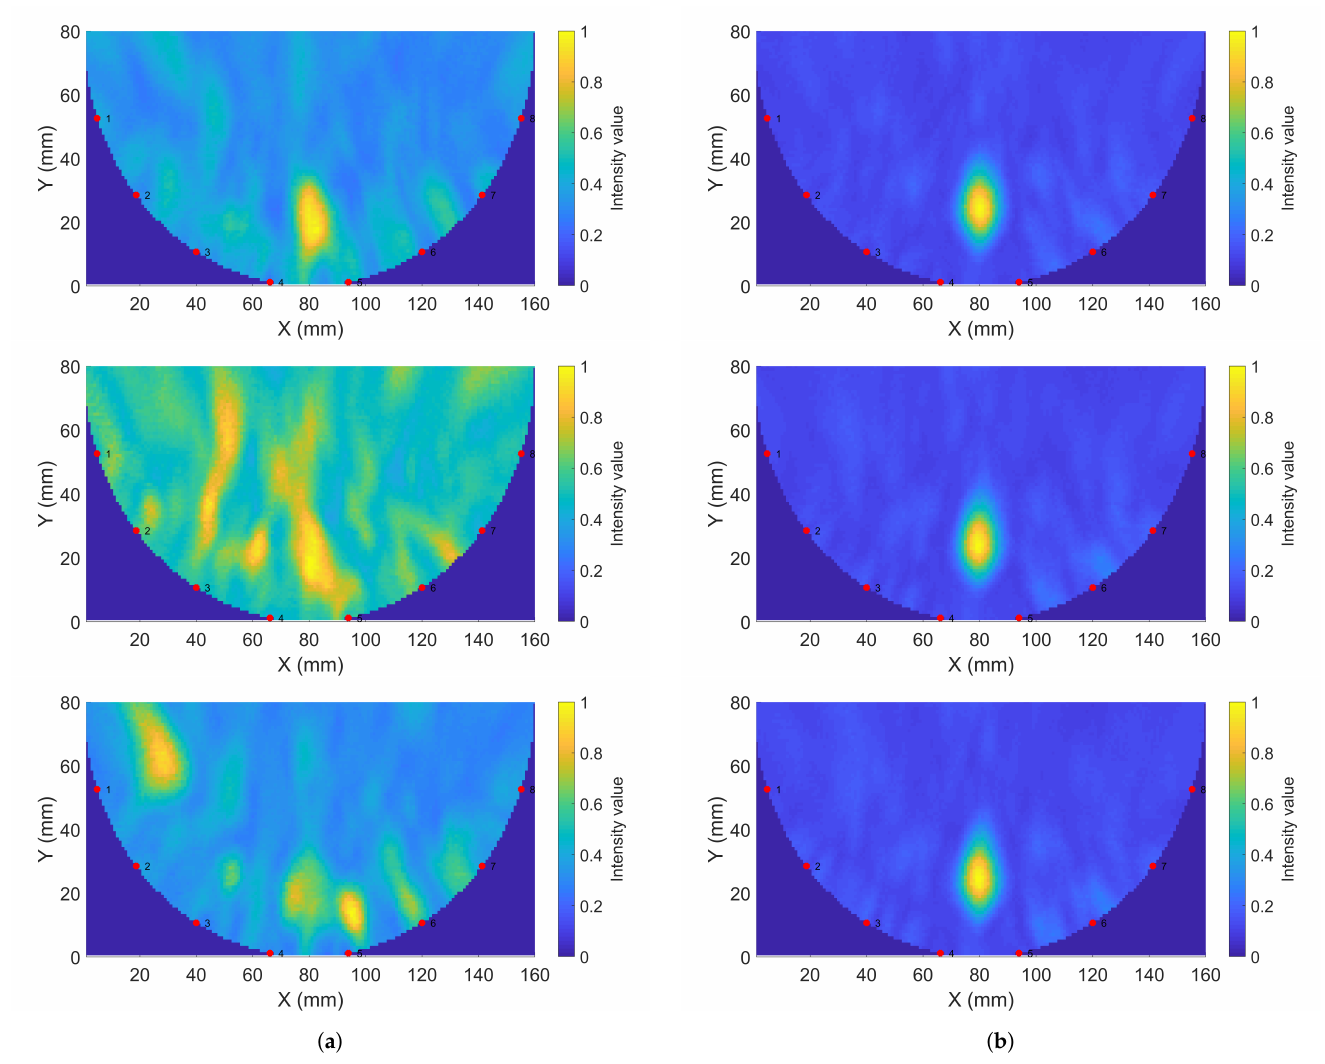
Figure 14. Sample reconstructions using phantom measurements: ( a ) Gel #1; ( b ) Gel #3.